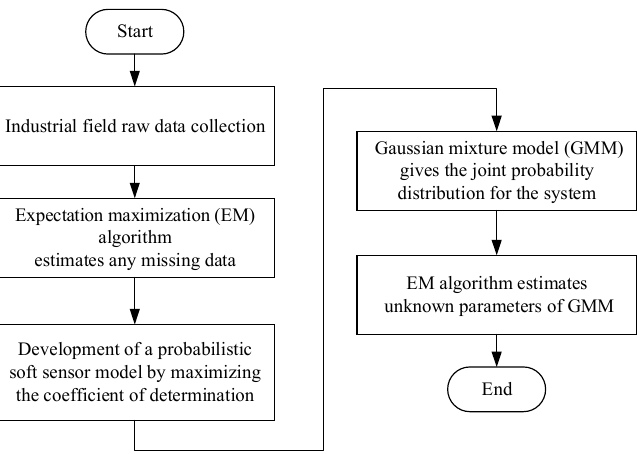
Figure 1. The flow chart of soft sensor development process.